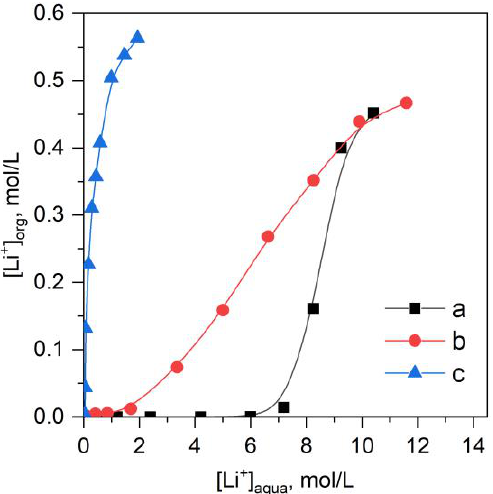
Figure 2. Lithium extraction isotherms in the systems: (a) LiCl-B15C5-CHCl 3 , (b) LiCl-B15C5- [C8mim][NTf 2 ], (c) LiNTf 2 -B15C5-[C8mim][NTf 2 ]. C 0B15C5 = 0.5 mol/L, O/A = 1, T = 23 ± 2 °C.